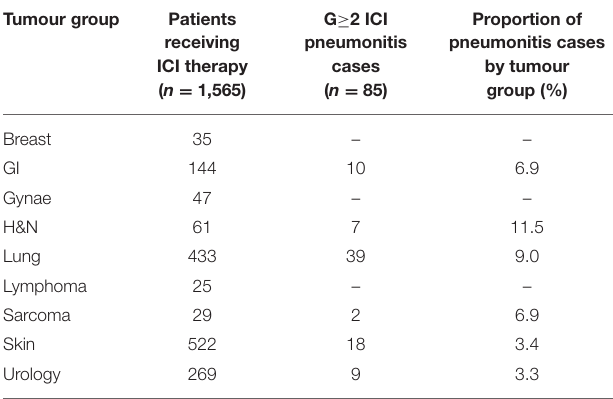
TABLE 3 | The number of patients receiving ICI therapy and developing symptomatic ICI-related pneumonitis between 2015 and 2020. Tumour